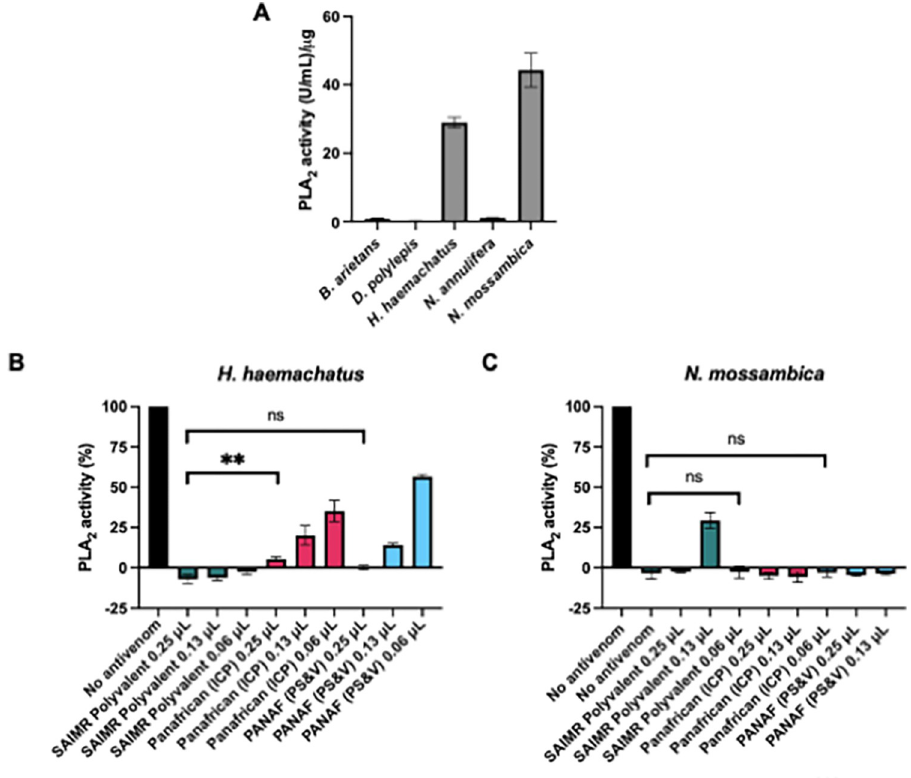
Fig 6. PLA 2 activity of five venoms from Eswatini and their neutralisation by different antivenoms. �� indicates p < 0.01 by one-way ANOVA. A: PLA 2 activity of B . arietans , D . polylepis , H . haemachatus , N . annulifera and N . mossambica . Data show the mean of three replicates and error bars represent standard deviation. Neutralisation of (B) H . haemachatus and (C) N . annulifera PLA 2 activity by the three antivenoms SAIMR Polyvalent (SAVP), Panafrican (ICP) and PANAF (PS&V) at different doses, expressed as a percentage of a no antivenom control showing 100% activity. Data show the mean of three replicates and error bars represent standard